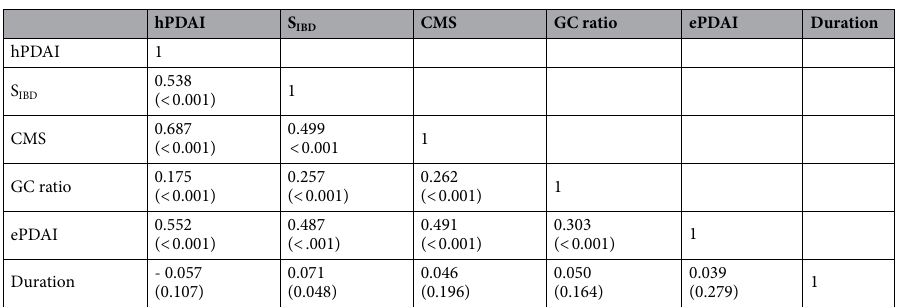
Table 2. Relationship between hPDAI S IBD , CMS, GC ratio, ePDAI and Duration. Correlation between the scores and duration. Values shown are the Spearman correlation coefficients and p values. hPDAI pouchitis disease activity index histology subscore; S IBD the IBD Score; CMS colonic metaplasia scores; GC ratio goblet cell ratio; ePDAI pouchitis disease activity index endoscopy subscore; Duration duration of ileal pouch use.